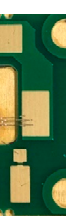
Figure 6. Comparison of nondestructive testing methods (NDTs) for soldered interconnects on four power LEDs. ( X1 ) to ( X4 ) show X-ray images, ( S1 ) to ( S4 ) show SAM images from backside with a 100 MHz transducer (images are vertically mirrored), Z1 and Z2 show Z th (t) plots, and B1 and B2 show the normalized logarithmic derivative, whereby ( X1 ), ( X2 ), ( S1 ), ( S2 ), ( Z1 ), and ( B1 ) belong to two LEDs of Type A and ( X3 ), ( X4 ), ( S3 ), ( S4 ), ( Z2 ), and ( B2 ) belong to two LEDs of Type B. For ( B1 ) and ( B2 ), the normalization interval was set between 0.1 ms and 1 ms resulting in a peak increase of 0.12 or 0.02.